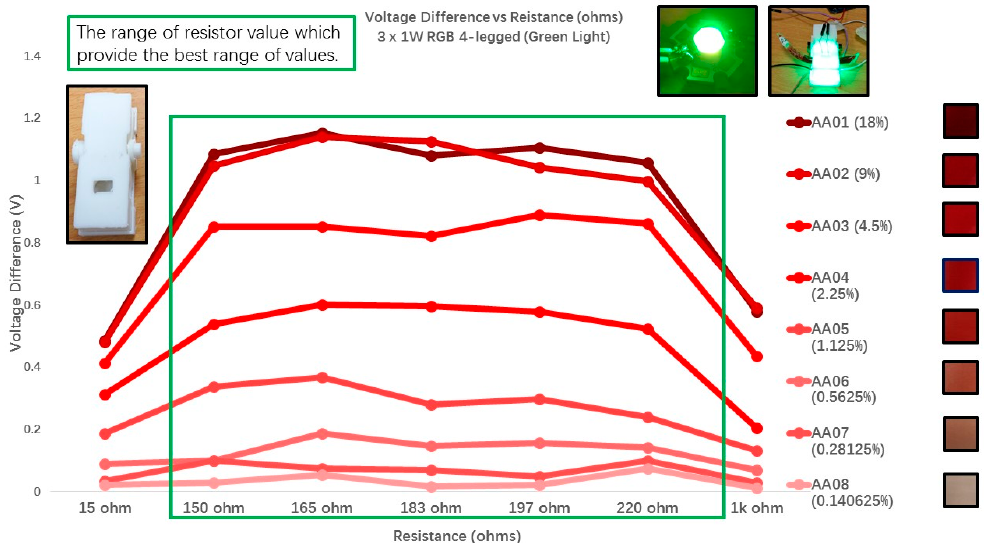
Figure 7. The resistor calibration test is conducted to find out the range of resistance would provide better detection. The experiment was conducted with the green color light spectrum, which shows the optimum range of resistance values are between 150 and 220 ohms.